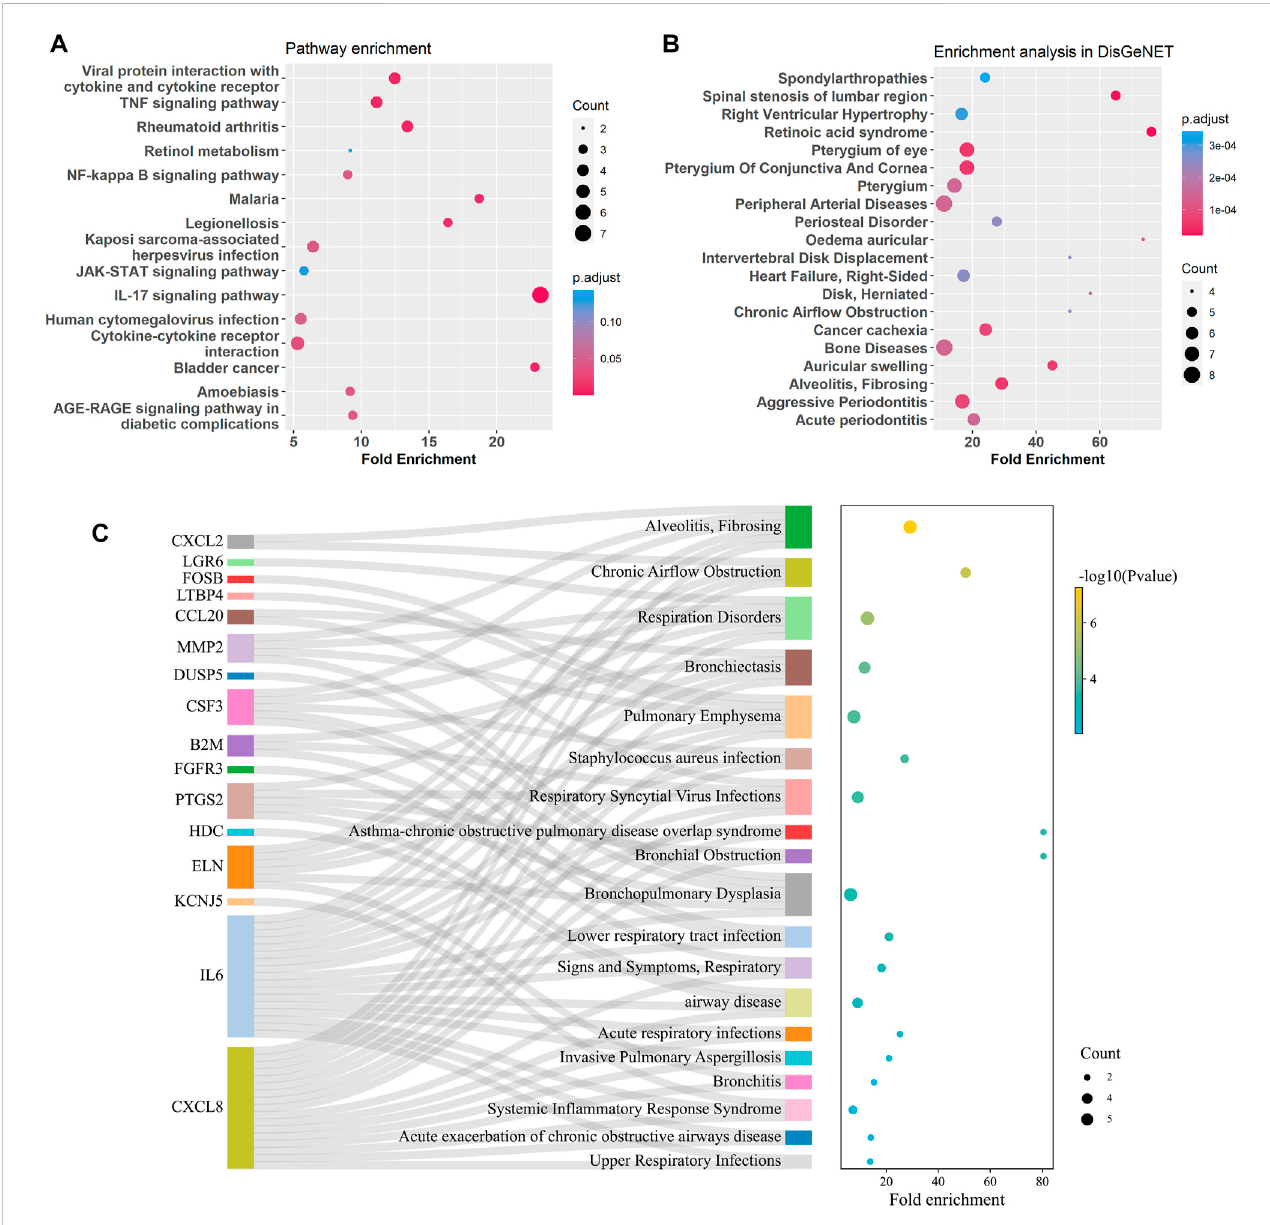
FIGURE 6 Enrichment analysis for age-related DEGs in the bronchus. (A) Summary of KEGG enrichment in the bronchus. (B) Summary of DisGeNET enrichment in the bronchus. (C) Sankey plot showed relation between age related-DEGs and signi fi cant enriched ( p adjust < 0.5) pulmonary diseases.